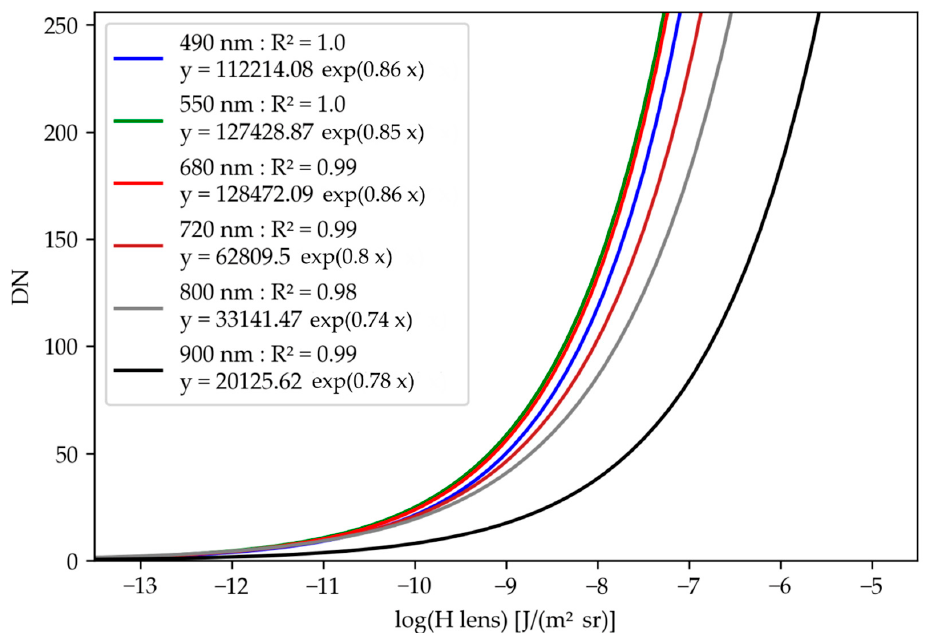
Figure 4. Response curves of the monochrome cameras. Each camera is designated using the central wavelength of the narrow-band optical filter. The response curves model the relation between image digital numbers (DNs) and exposure at camera lens ( H (cid:2922)(cid:2915)(cid:2924)(cid:2929) ).